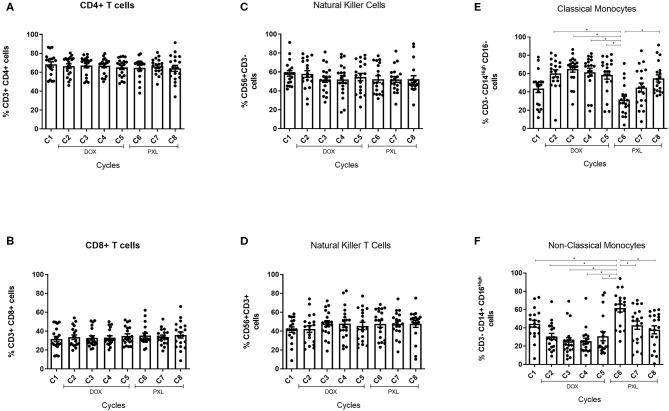
Peripheral blood mononuclear cells characterization under NAC in BC patients. Cells were obtained from the PBMC previously extracted from blood samples of BC patients (n = 20) and the characterization were performed by flow cytometry. The percentage of CD4+ and CD8+ cells was calculated from the CD3+ and showed across the NAC treatment in (A,B), respectively. The percentage of NK cells was calculated from the CD56+ and CD3Neg and the data was showed across the NAC in (C). Also, the percentage of NKT cells was calculated from the CD56+ and CD3+ and was showed in (D). The percentage of classical monocytes was calculated from the CD14High CD16Neg gated in CD3Neg
(E) and the non-classical monocytes was calculated from the CD14+ CD16High percentage (F). The cycle 1 (C1) was the percentage of cells without the effect of the treatment (baseline). The statistical significances were assessed using a One-way ANOVA test *p < 0.05.